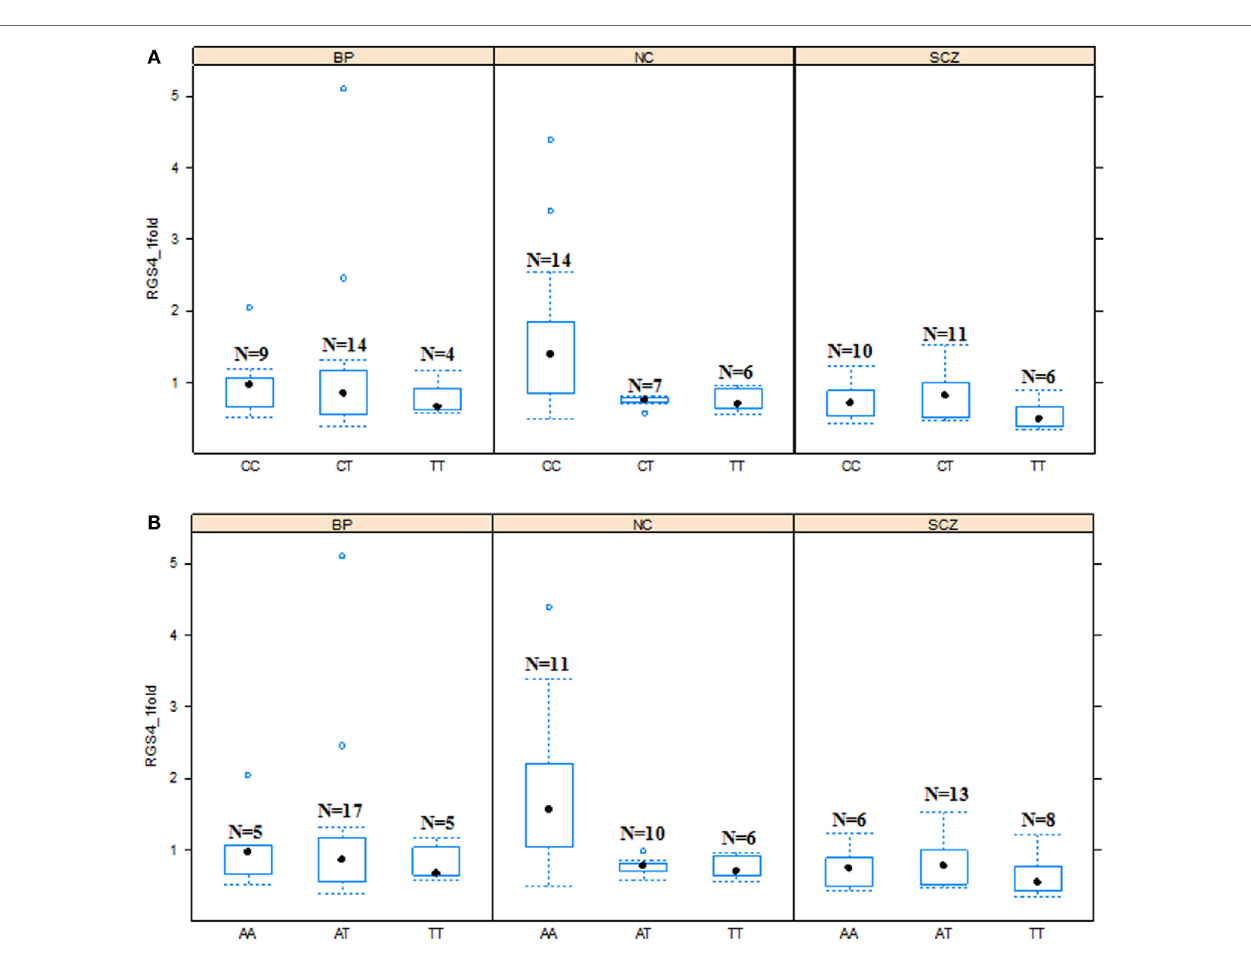
FigUre 3 | effects of snP1 and rs2661347 genotypes on RGS4-1 mrna expression among the groups . In the schizophrenia group (SCZ), the RGS4-1 mRNA expression level in the subjects with genotype CC of SNP1 were lower than the people in the normal control (NC) group with same genotype CC (adjusted p = 0.0324) of SNP1 (a) . In the SCZ group, the patients with the genotype AA of rs2661347 ( p = 0.0984) tended to have lower mRNA expression than those with the same genotype in the NC group (B) . Boxes represent 25th and 75th percentile distribution. Bars outside the box represent the